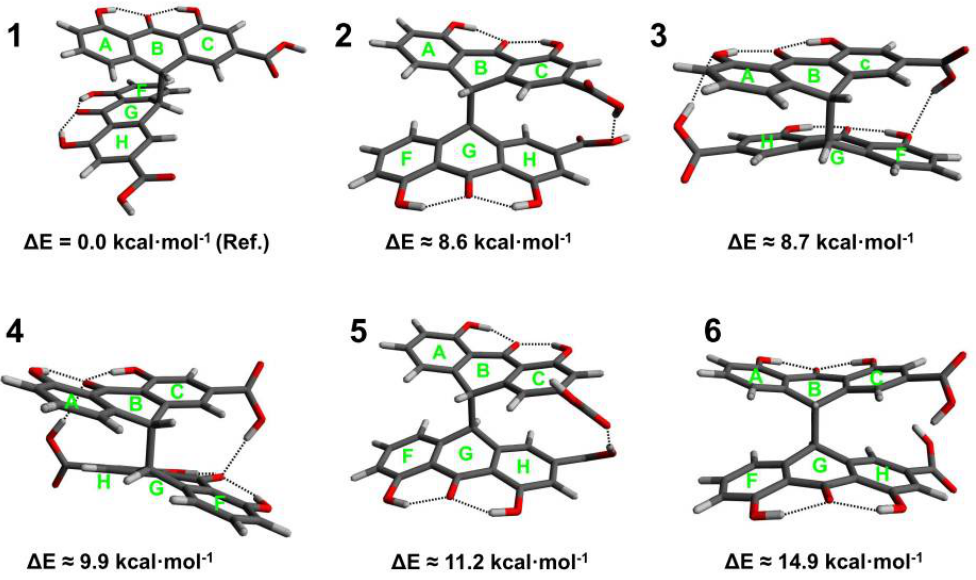
Figure 1. Conformers ( 1 – 6 ) of sennidin A.